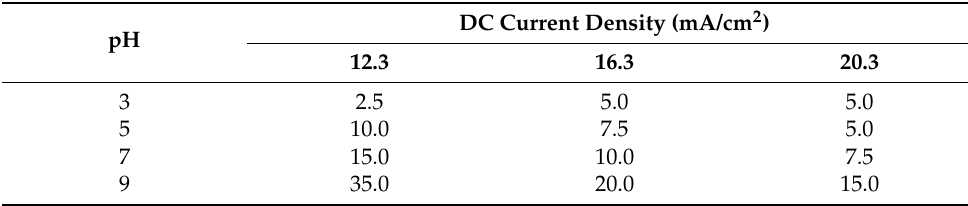
Table 2. Reaction times (min) for electrochemical oxidation of naproxen in surface